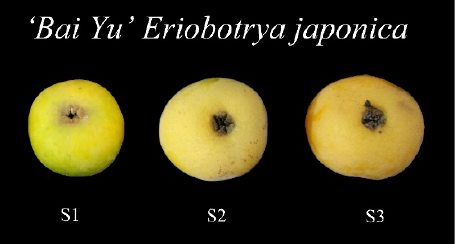
Figure 1. Loquat at different periods. Note: S1—6 May 2021, period S2—16 May 2021, and period S3—26 May 2021.